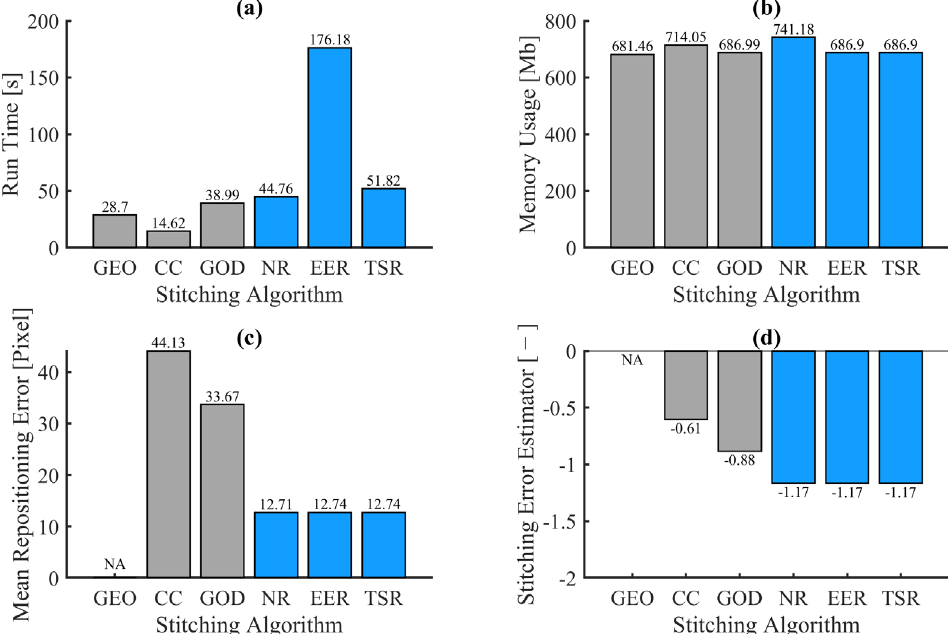
Figure 13. Bar charts of the quantitative criteria for test case C: run time ( a ), memory usage ( b ), mean repositioning error ( c ) and stitching error estimator ( d ). NA = Not Applicable.